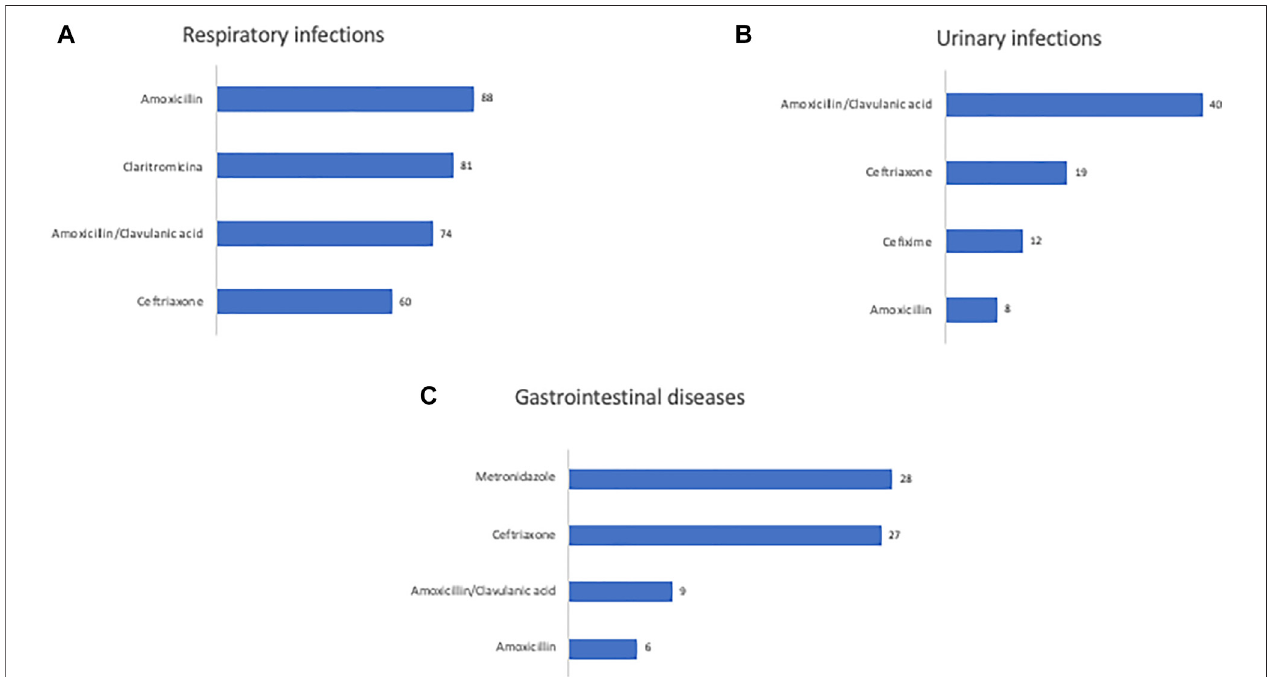
FIGURE 1 | Number of antibiotics prescriptions used for the main diagnoses of patients admitted to pediatric units.